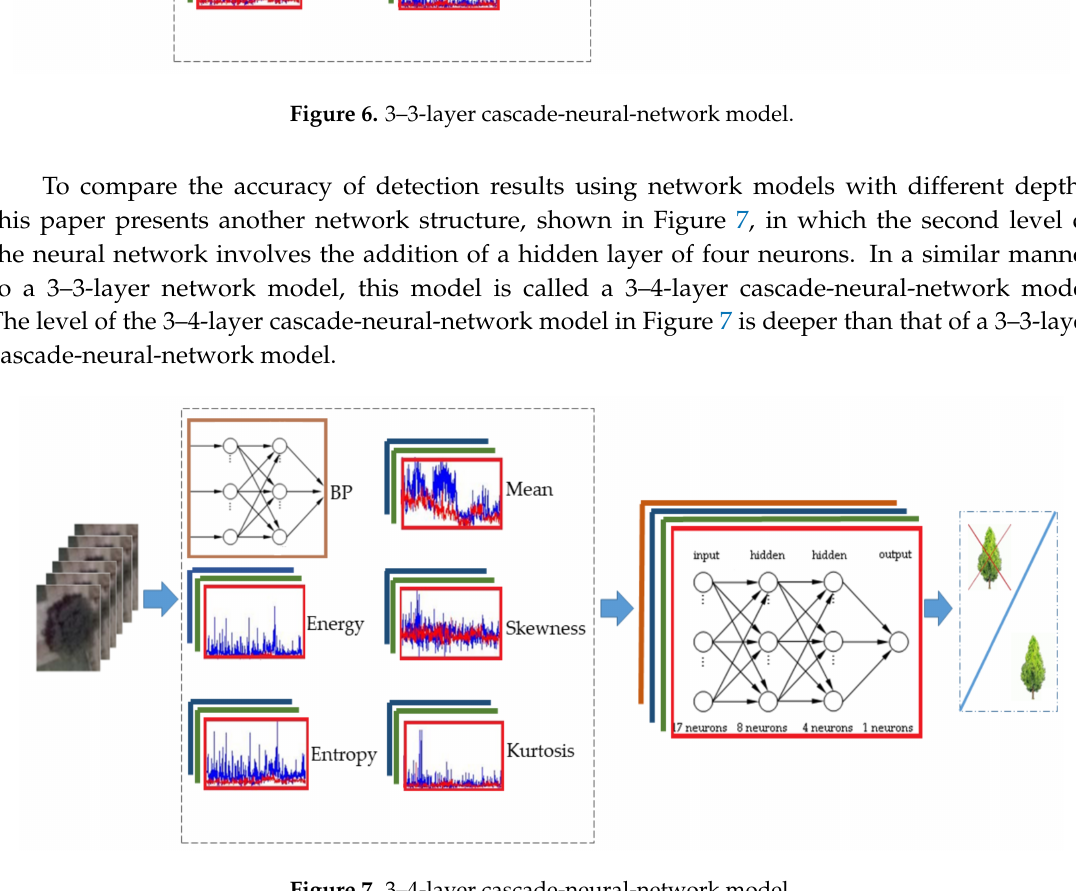
Figure 7. 3–4-layer cascade-neural-network